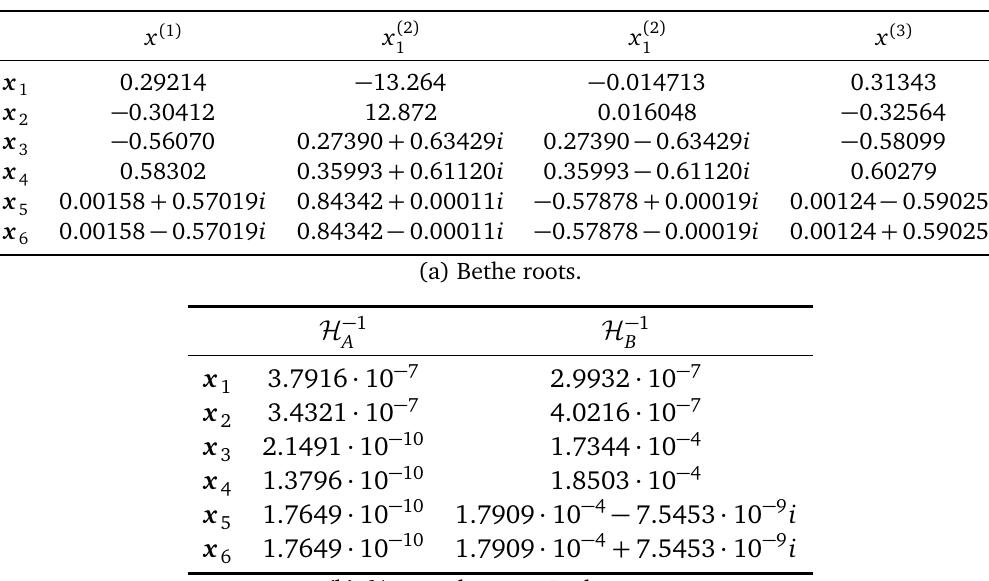
Table 7: Bethe roots and value of A / B-twisted handle-glue operator for quiver gauge theory (6.21) mirror to U ( 2 ) SQCD.